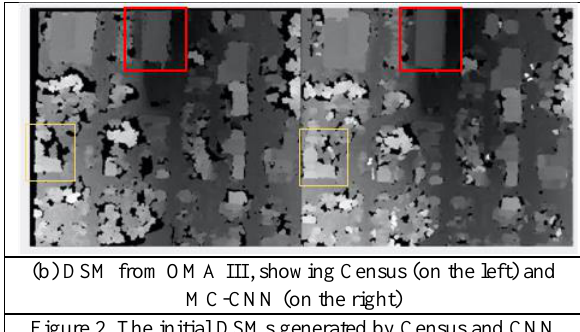
(b) DSM from OMA III, showing Census (on the left) and MC-CNN (on the right) Figure 2. The initial DSMs generated by Census and